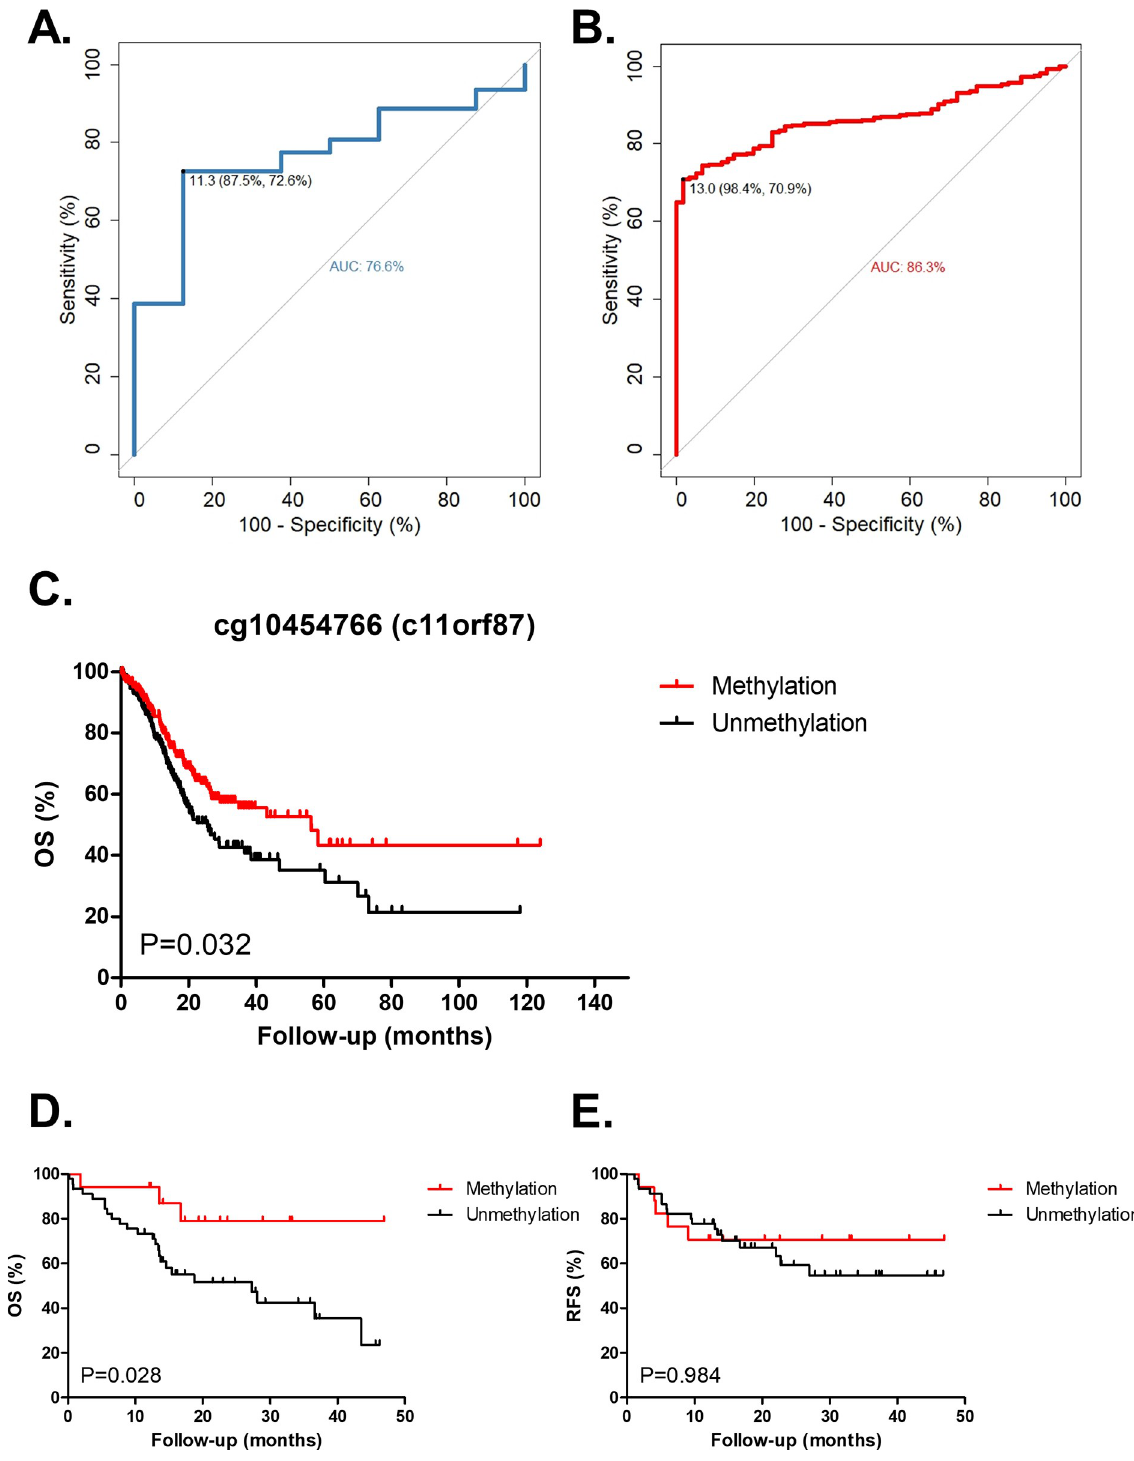
Fig 5. The methylation of C11orf87 served as a biomarker for diagnosis and diseases outcome. (A) ROC curve of C11orf87 methylation in our in-house samples, including 8 gastritis and 62 gastric cancer samples. (B) ROC curve of cg10454766 methylation in combined datasets (GSE103186 and TCGA), including 61 normal samples from GSE103186 and 385 tumor samples from TCGA. The best cut-off methylation value for specificity and sensitivity is shown (black dot). (C) Kaplan-Meier analysis of patients with differential C11orf87 methylation status for overall survival (OS) in gastric cancer TCGA dataset (n = 385). Patients were divided into two groups according to the median value of methylation (median = 29.77%). Kaplan-Meier analysis of (D) OS and (E) recurrence-free survival (RFS) in gastric cancer patients from Taiwan. Patients were divided according to same median value from TCGA cohort. P-value is shown from the Log-rank (Mantel-Cox) test.